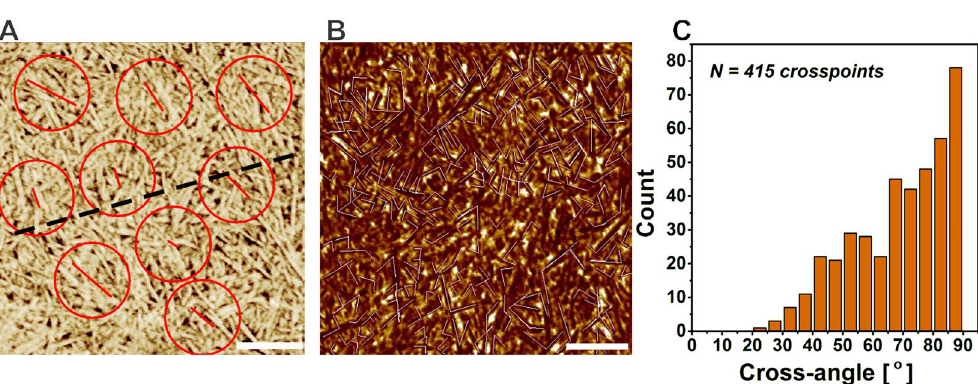
Figure 3. Fibril orientation at the surface of the aggregate. ( A ) AFM phase image from the surface of an SFA. Red circles are the selected areas for which the local director (red lines) was computed. The dashed line represents the central axis of the SFA (a central axis of an SFA can be seen in Fig. 2A–C). ( B ) Representative AFM image with measured fibril cross-angles and ( C ) the corresponding distribution of cross-angles. Scale bars are 500